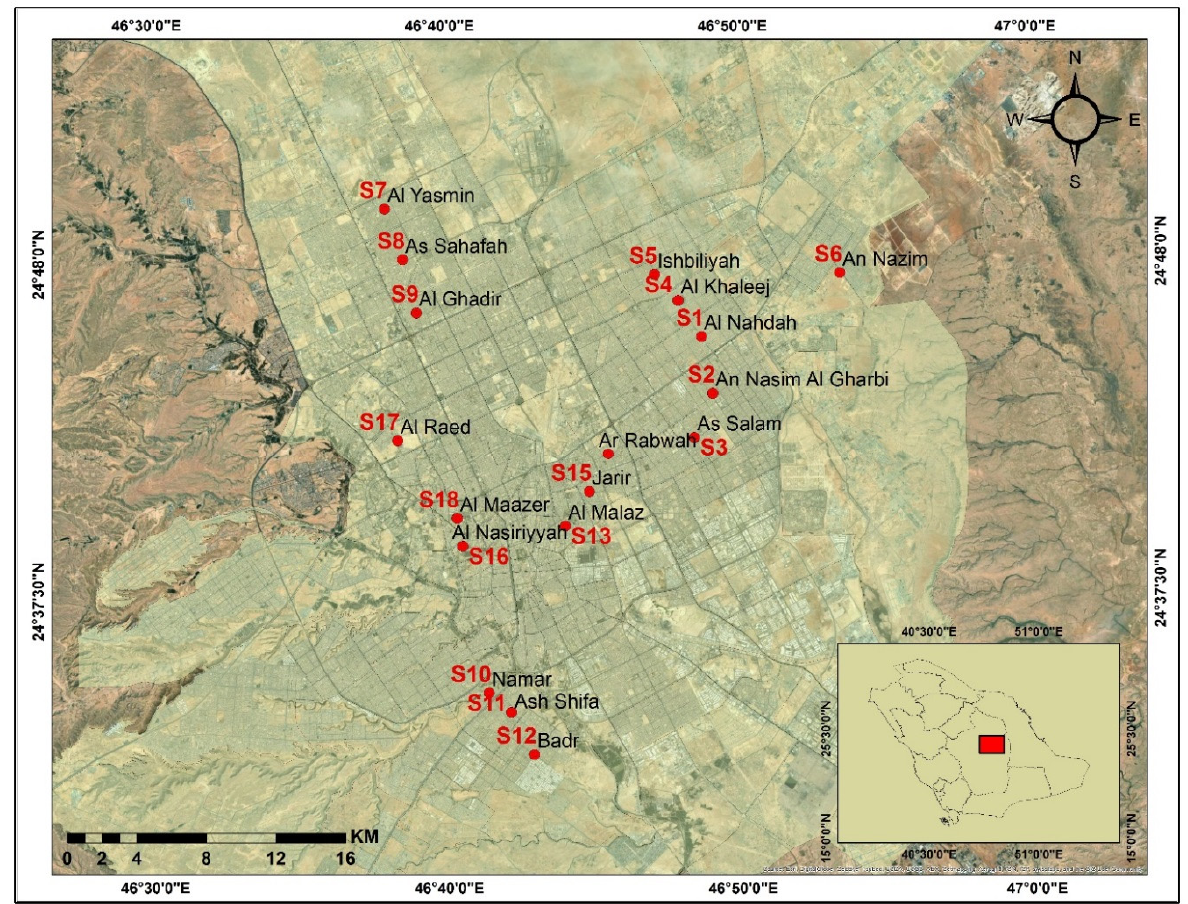
Figure 1. Dust sampling sites from the outdoor and indoor environment of elementary schools.